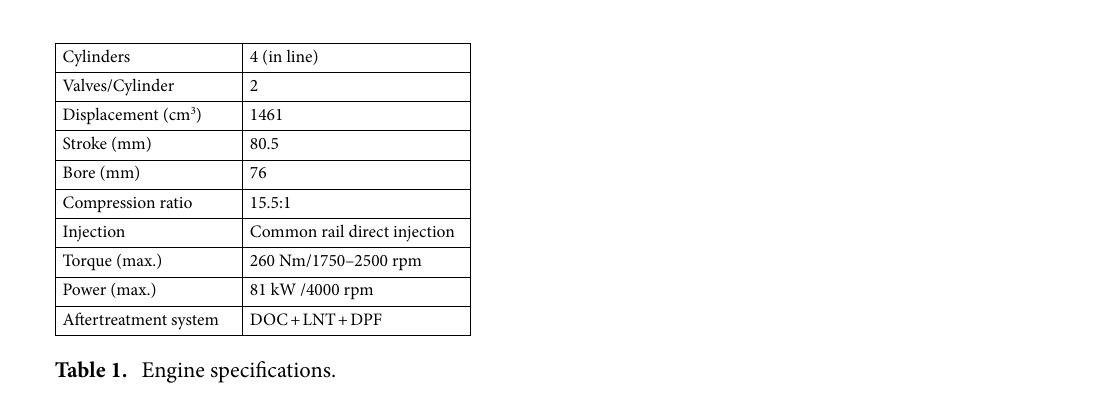
Figure 1. Experimental setup for engine tests.